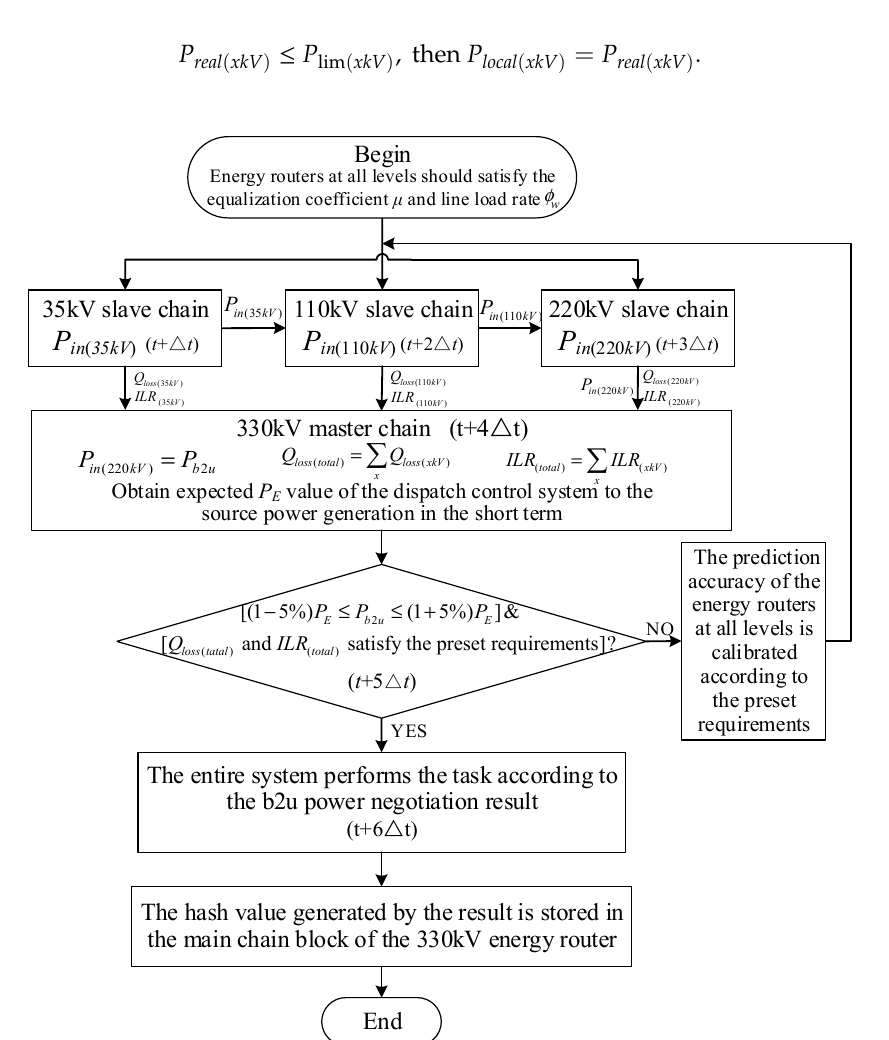
Figure 4. Blockchain-based transmission and distribution network consultation mechanism.